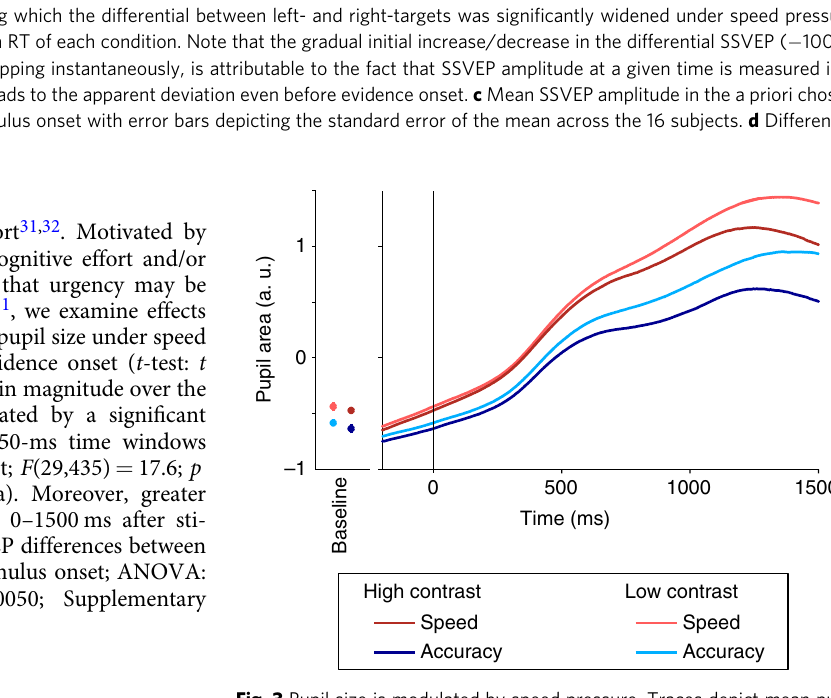
Fig. 3 Pupil size is modulated by speed pressure. Traces depict mean pupil size plotted over time aligned to evidence onset. Traces are baseline- corrected with respect to the average pupil size in a − 500 to 0 ms time window with respect to the onset of the regime-cue. Pupil size was increased under speed pressure (red traces) starting just before evidence onset. The left panel shows the mean pupil size at the onset of evidence presentation for all four conditions with error bars indicating S.E.M. across the 16 subjects. The effect of speed pressure increased in magnitude over the course of evidence presentation, visible in the increasing separation between red and blue